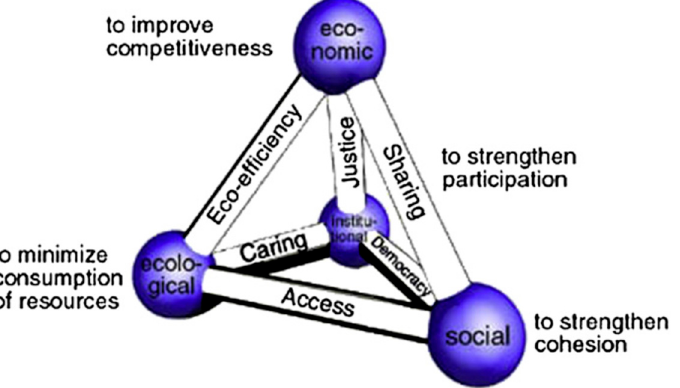
Figure 1. The Prism of Sustainability. Adapted with permission from Ref. [31]. Copyright 2010 Elsevier.